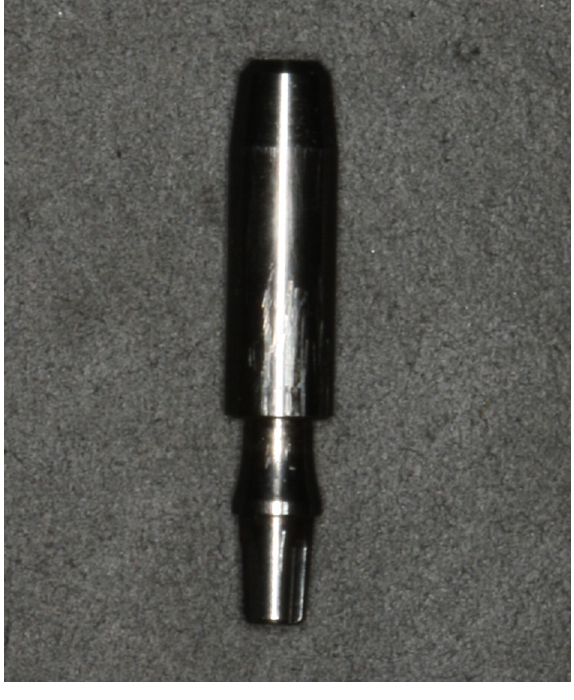
Figure 1. Implants that were specifically produced without external threads to allow for strain gauge